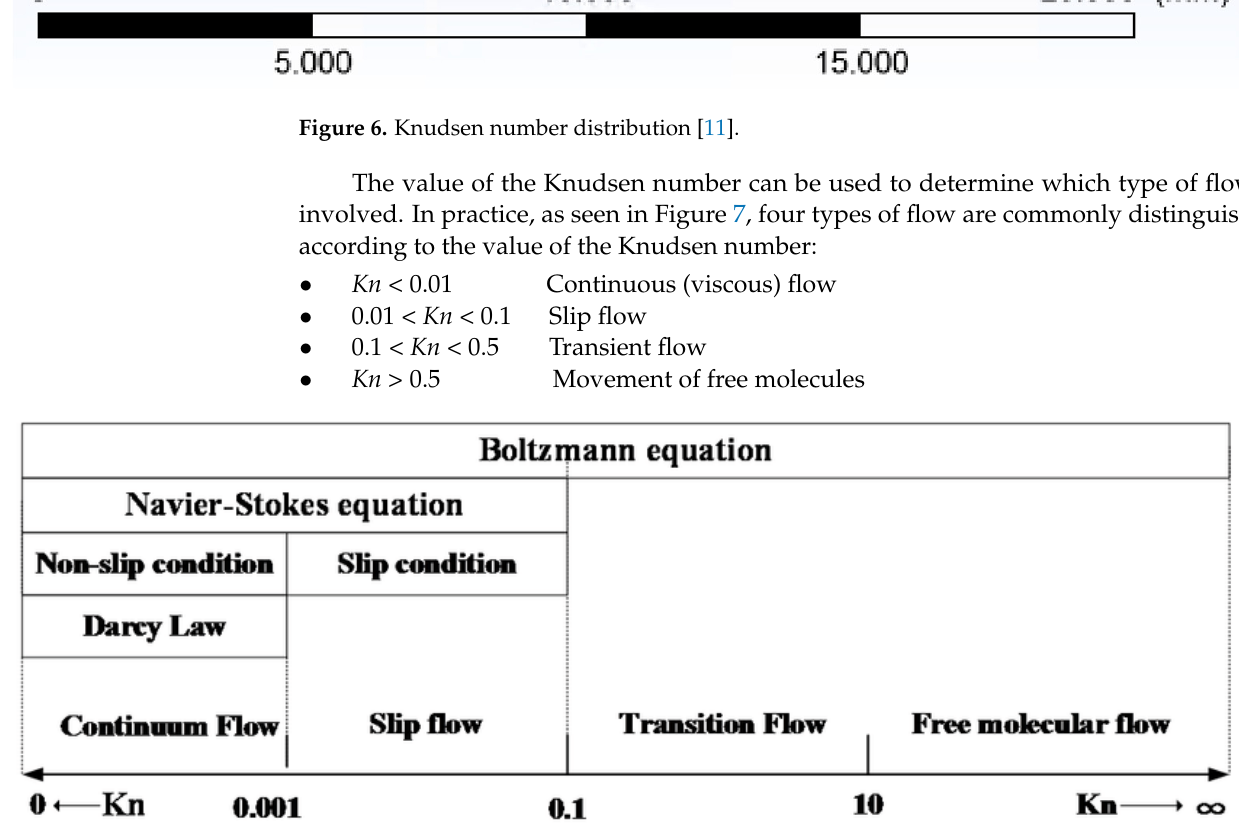
Figure 7. Flow regimes as a function of Knudsen number.